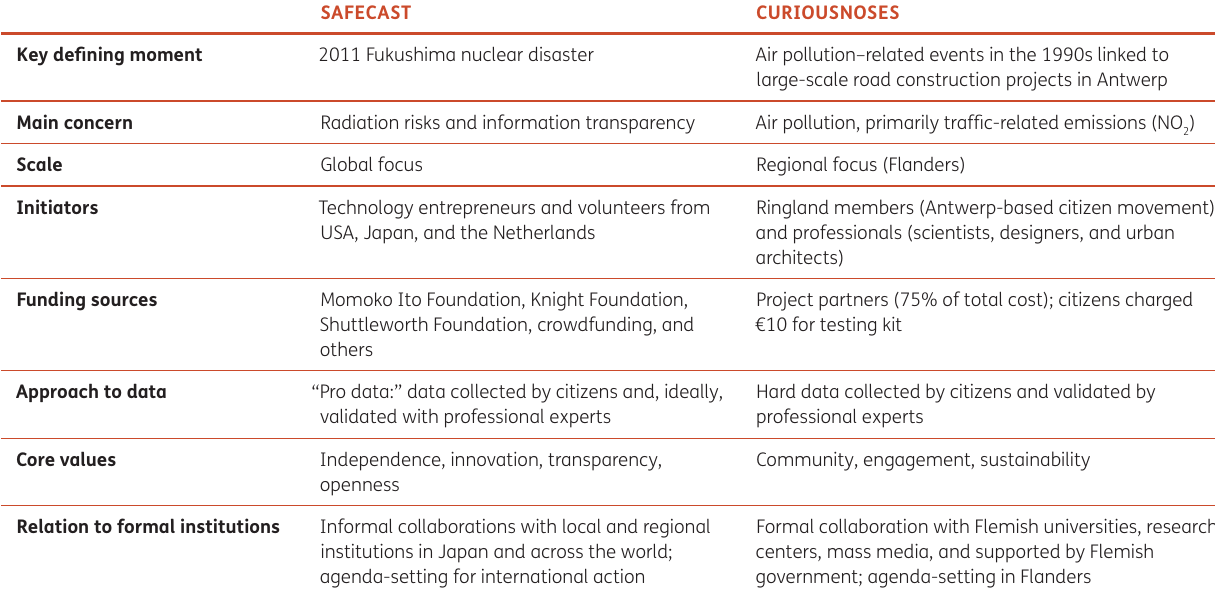
Table 1 Safecast and CuriousNoses side by